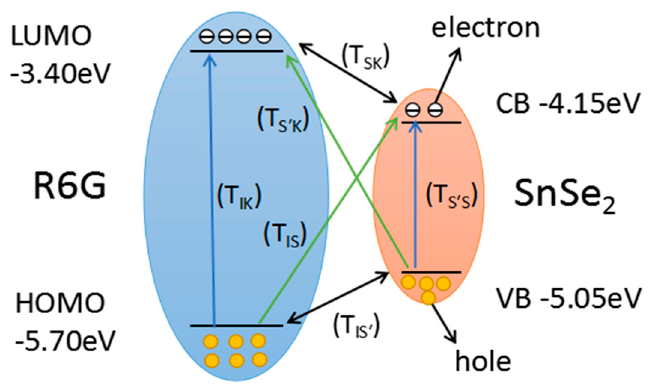
Scheme 1. Schematic energy diagram illustrating charge transfer process between R6G molecule and SnSe 2 under the excitation of 532 nm.